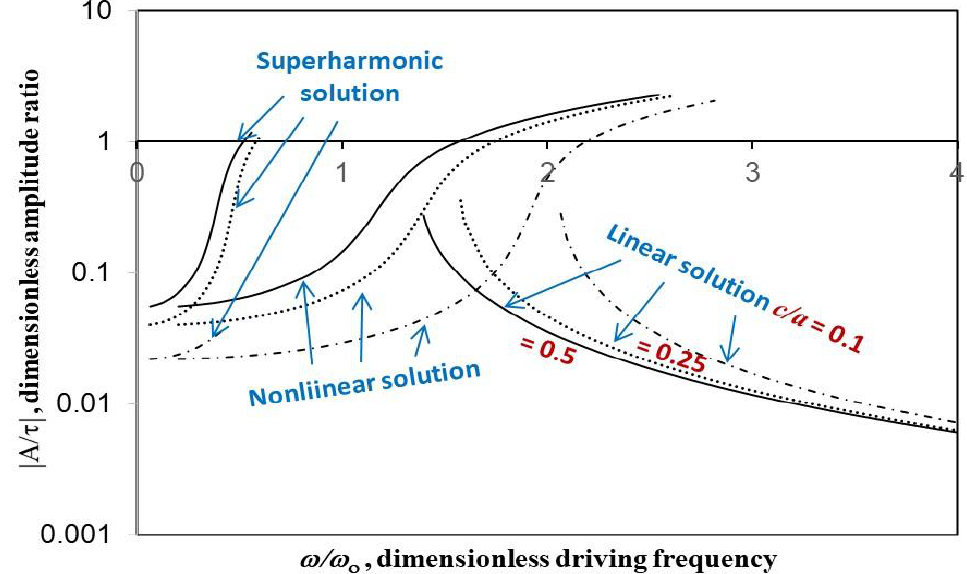
Figure 5. Amplitude ratio versus excitation frequency for various cavity depths ( k = 5, ξ = 0.02, single cavity).